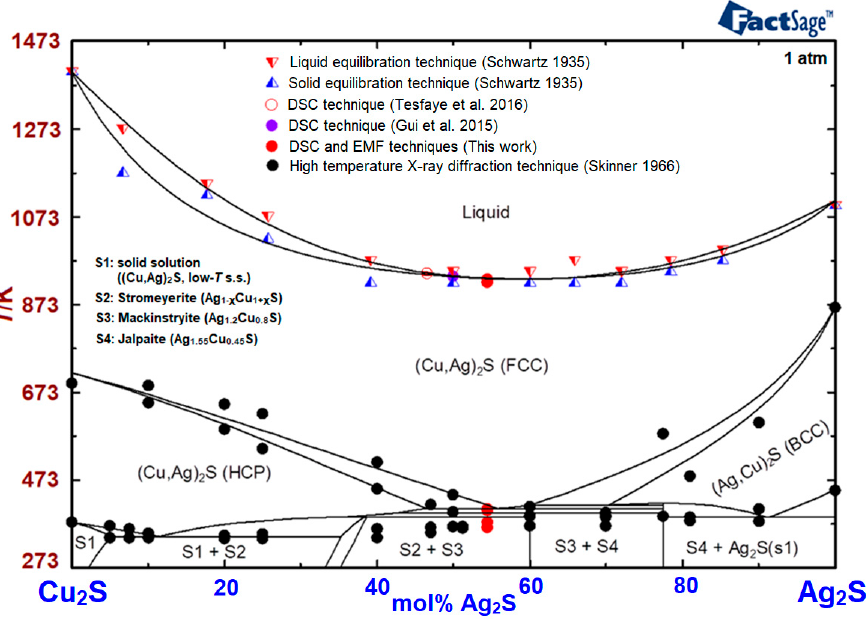
Figure 9. Optimized phase diagram of the Ag 2 S-Cu 2 S system with super imposed literature data [4,6,18,29] and the experimental data determined in this work.